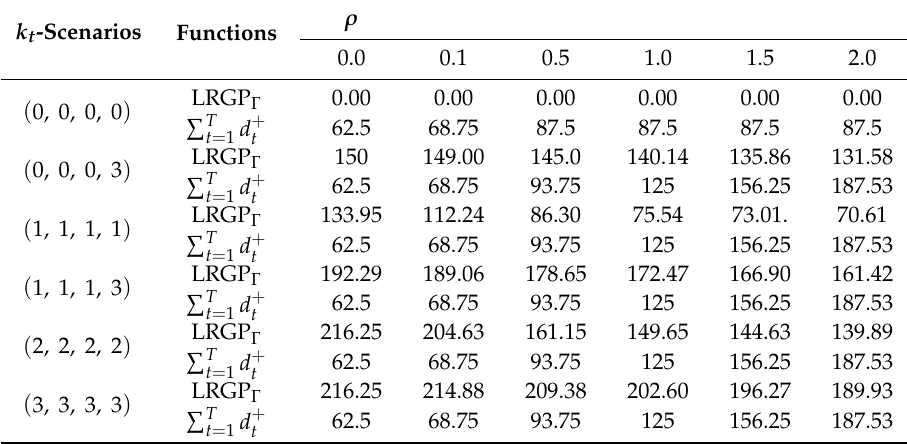
Table 4. E ff ect of regret using LRGP via Γ -robustness.